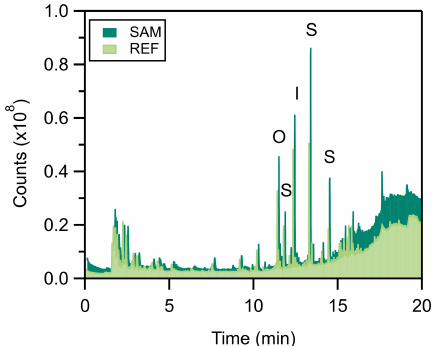
Figure 4. Stacked chromatograms of the background composition of the LI-6800, comparing measurements taken from the REF (light green) and SAM (dark green) ports as sampled by TD-GC/MS (20min at 0.2Lmin − 1 , sampled on Tenax cartridges). The five largest peaks are labeled: S is the result of a siloxane, I is that of isobornyl acrylate, and O is that of n -octyl